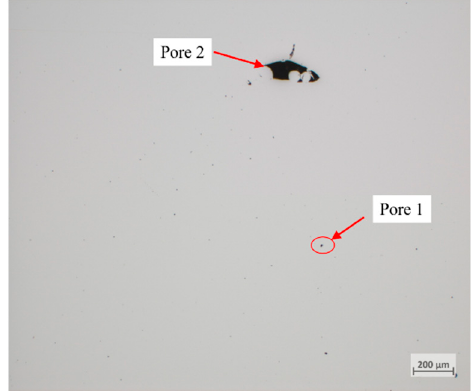
Figure 9. Pore defect morphology.